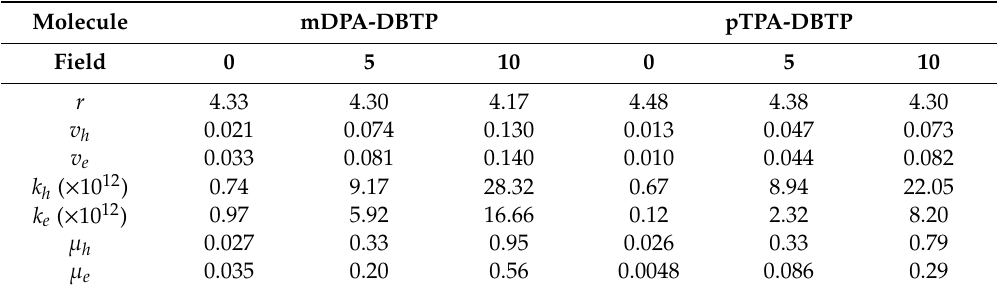
Table 2. The transfer integrals v (eV), hopping rates k (s − 1 ), and mobilities µ (cm 2 V − 1 s − 1 ) of molecules in the electric field ( × 10 − 4 a.u.).